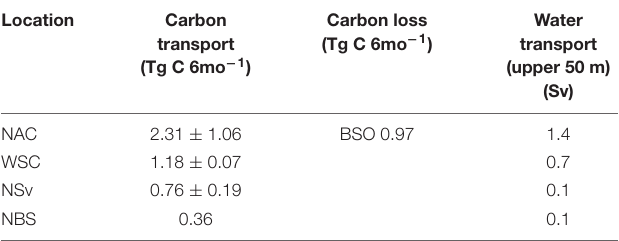
TABLE 1 | Carbon in Tg C 6mo − 1 (average ± standard deviation) and water (Sv) within the upper 50-m of the water column transported northwards by the Atlantic Water Inflow at different locations spanning 11 degrees of latitude from northern Norway to southern Arctic